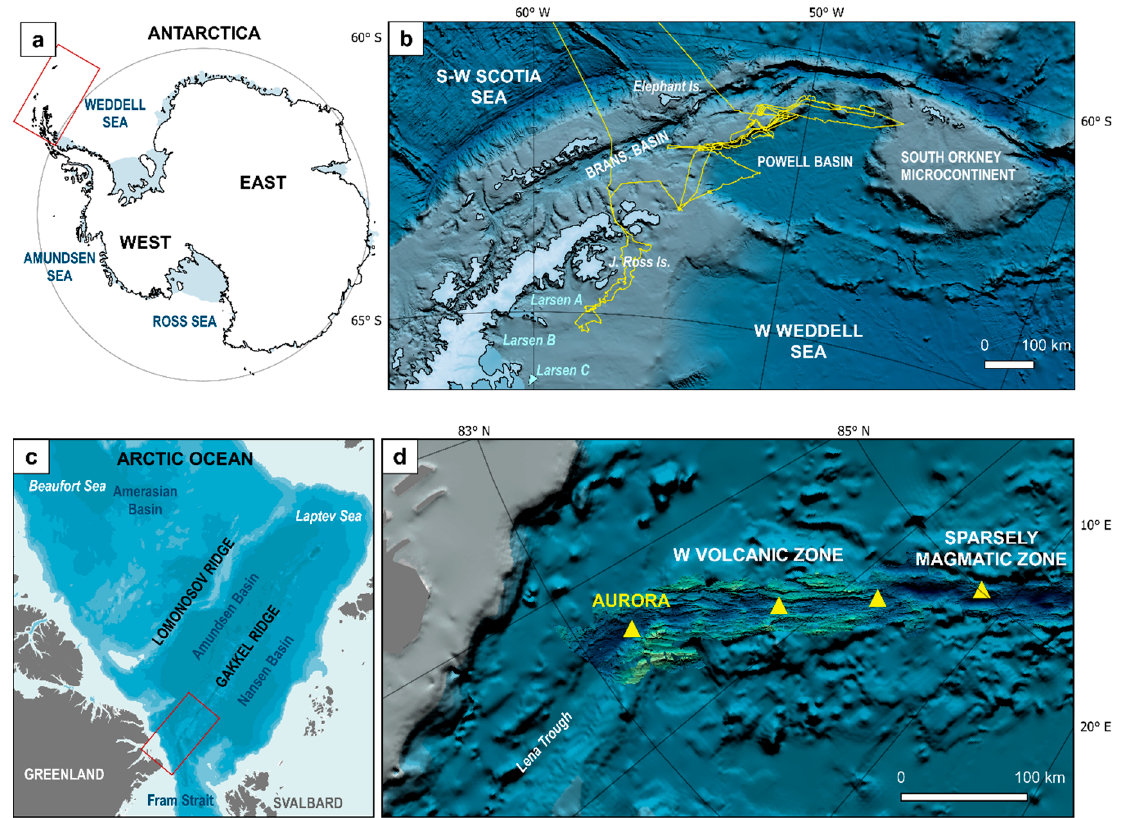
Figure 1. ( a ) Overview map of Antarctica, Antarctic Circle, and the working area marked with a red box. Polarstern Expedition PS118 targeted the western Weddell Sea, which is bound by the Antarctic Peninsula to the west. ( b ) Close up of the working area and the ships track highlighted in yellow. Elevation is from BedMachine Antarctica [6]. ( c ) Overview map of the Arctic Ocean, location of the Gakkel Ridge, and the working area bound by a red box. ( d ) Close up of the working area in the Western Volcanic Zone of the Gakkel Ridge and locations of identified vent fields [7] marked by yellow triangles. The Aurora Vent Field is located in the western part of the volcanic zone towards Lena trough. Low-resolution bathymetry is the International Bathymetric Chart of the Arctic Ocean (IBCAO) [8] and high-resolution bathymetry from [7].